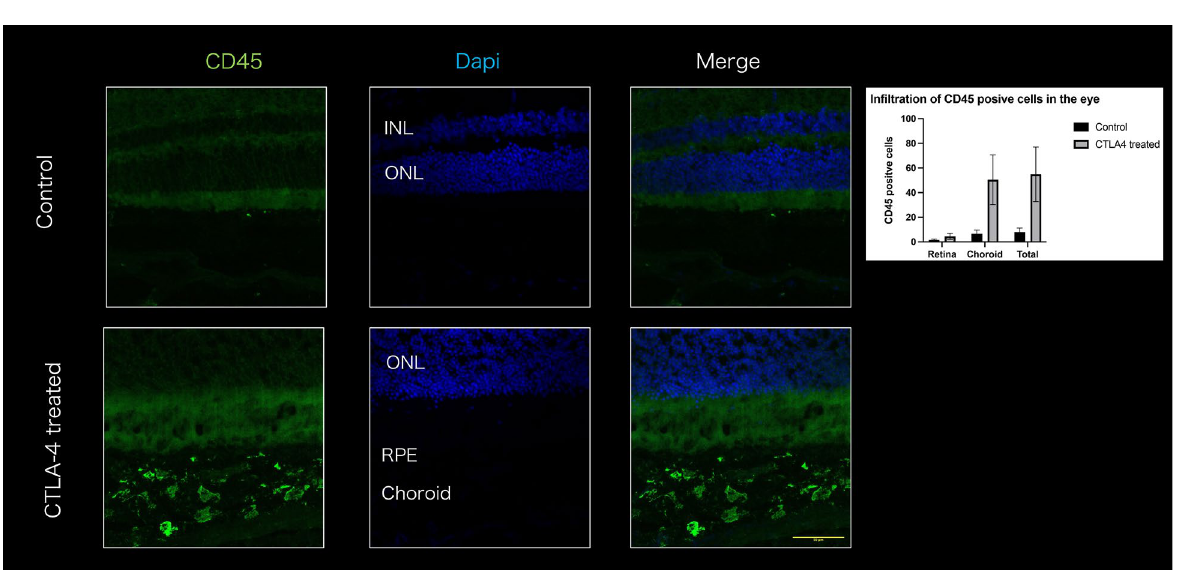
Figure 6. ZO1 staining in control and anti-CTLA4-treated eyes. Misalignment and discontinuous staining were observed in treated eyes (n = 3 in each group).